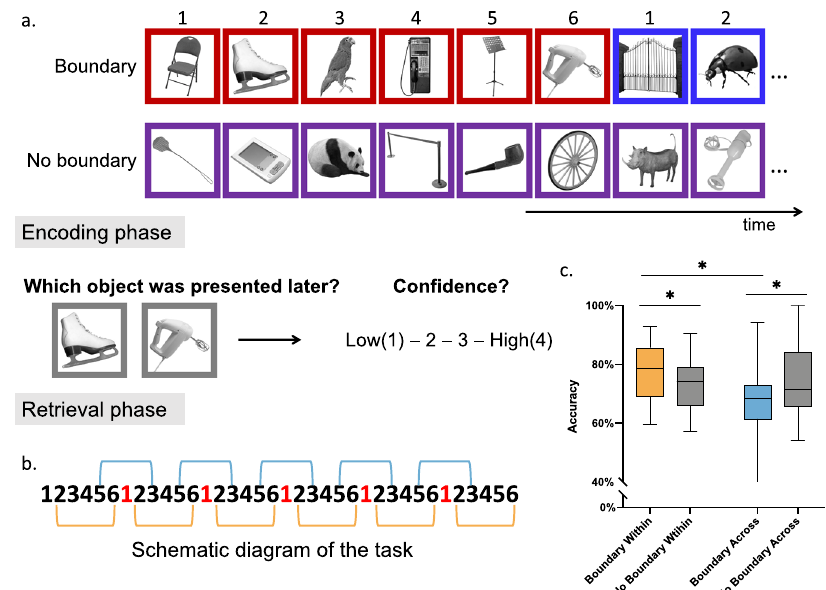
Fig. 1 Experimental paradigm. a Experimental task. 36 grey-scaled trial-unique object images embedded in a coloured frame were sequentially presented to participants. In the boundary condition, the colour of the frame was consistent for six consecutive images before switching to another one, while in the no boundary condition, the colour of the frame was consistent for all 36 objects. Each object image was presented to participants for 2.5 s, preceded by 0.5 s fi xation cross and followed by 2 s inter-trial interval, during which the coloured frame stayed on the screen. In the boundary condition, event boundaries were de fi ned as the trial in which the colour of the frame updated with the co-occurring object. Immediately after encoding the 36 images, participants made recency judgments on pairs of items from the just-encoded sequence. Each recency judgment was then followed by a con fi dence rating for each decision on a four-point scale. Participants had a self-paced short break after fi nishing each sequence. The images used were taken from publicly available dataset (Bank of Standardized stimuli, BOSS, https://sites.google.com/site/bosstimuli/, © 2010 Brodeur et al. & © 2014 Brodeur et al.) 49,50 . b Schematic diagram of the task in Experiment 1. Numbers in red depict event boundaries. There were two pair types marked by yellow and blue square brackets, denoting within-event pairs and across-event pairs respectively (short for Boundary Within and Boundary Across in the fi gure respectively). The two pair types were separated by the same number of intervening items. In the no boundary condition, item pairs took identical list positions as in the boundary condition (short for No Boundary Within and No Boundary Across respectively). c Group averaged temporal order memory for within and across- event pairs in the boundary vs. no boundary conditions in Experiment 1 ( n = 26). A repeated measures ANOVA on the accuracy of recency judgments showed a signi fi cant interaction between Condition and List Position (F (1, 25) = 18.05, p < 0.001, η 2 = 6.364%), as well as a main effect of List Position (F(1,25) = 5.339, p = 0.0294, η 2 = 3.452%). Simple effect analyses showed that TOM was signi fi cantly better for within than across-event pairs in the boundary condition (t(25) = 5.216, p < 0.001, two-sided, q < 0.05, FDR corrected for multiple comparisons), and was signi fi cantly better for within-event pairs (t(25) = 2.418, p = 0.0232, two-sided, q < 0.05, FDR corrected) and signi fi cantly worse for across-event pairs (t(25) = − 4.022, p < 0.001, two-sided q < 0.05, FDR corrected) in the boundary condition compared to matched pairs in the no boundary condition. The boxes in box plots show the inter-quartile range (IQR) and the median. Whiskers in box plots represent the minimum and maximum in the dataset. The asterisk (*) represents statistical signi fi cance at p < 0.05. Source data are provided as a Source Data fi